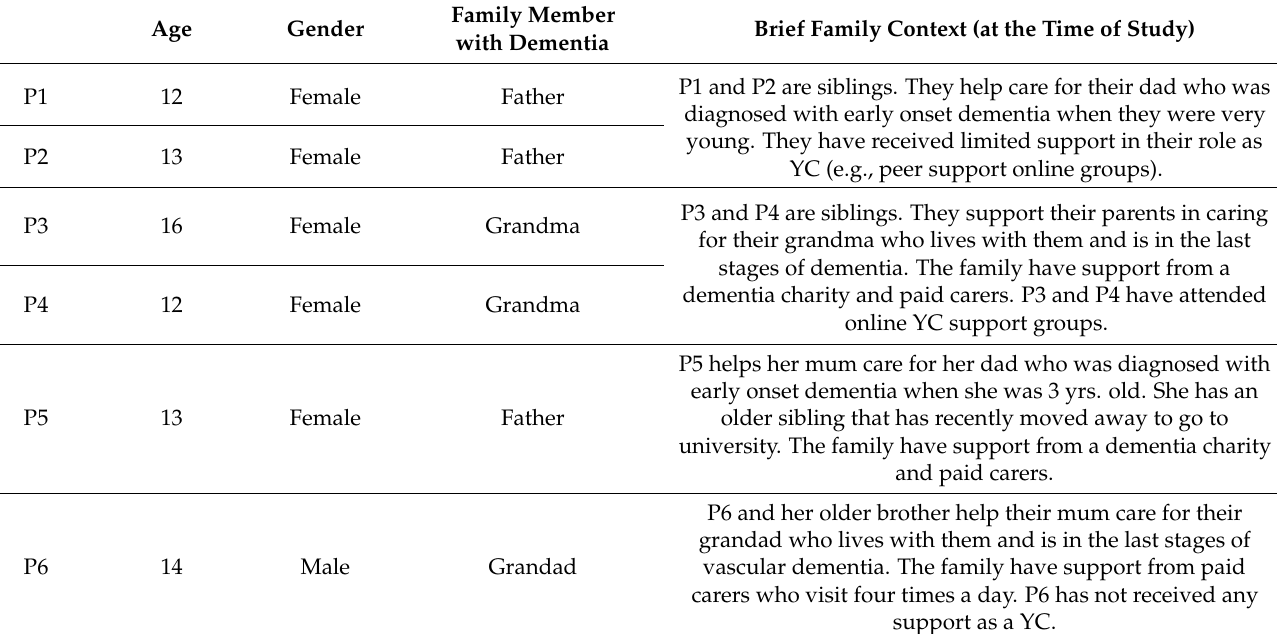
Table 2. Characteristics of young carers (YC) who took part in the